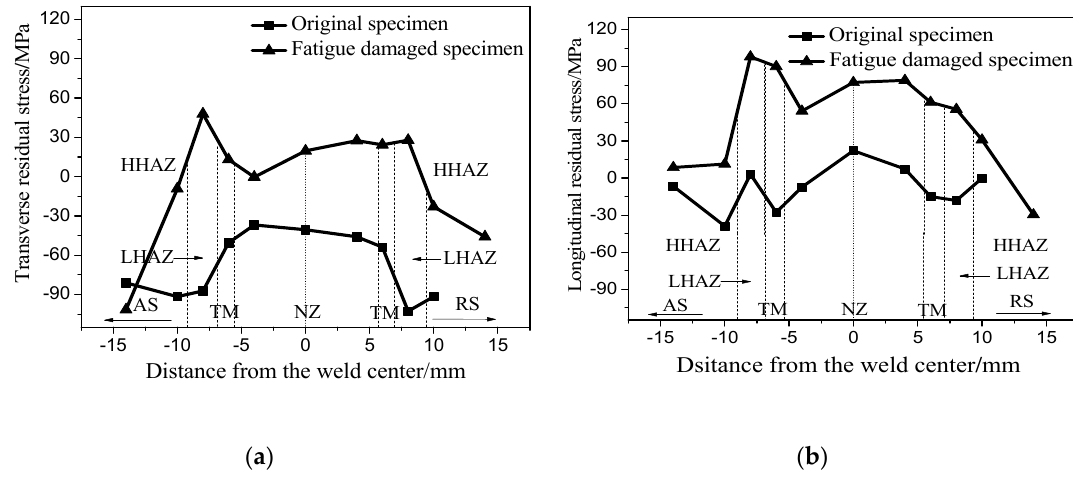
Figure 5. ( a ) Transverse and ( b ) longitudinal residual stress distributions of upper surface in the joint.